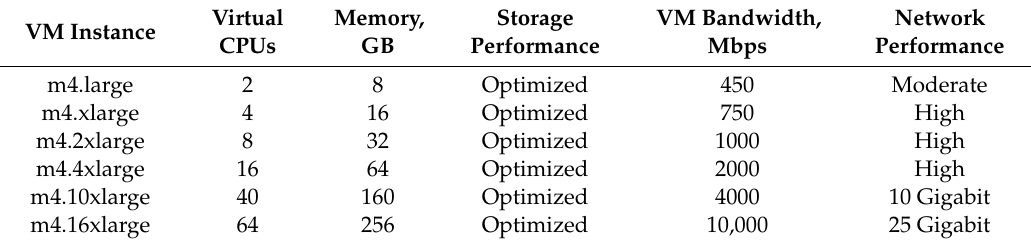
Table 3. Amazon Web Services (AWS) instances of the M4 type with optimized storage [21].